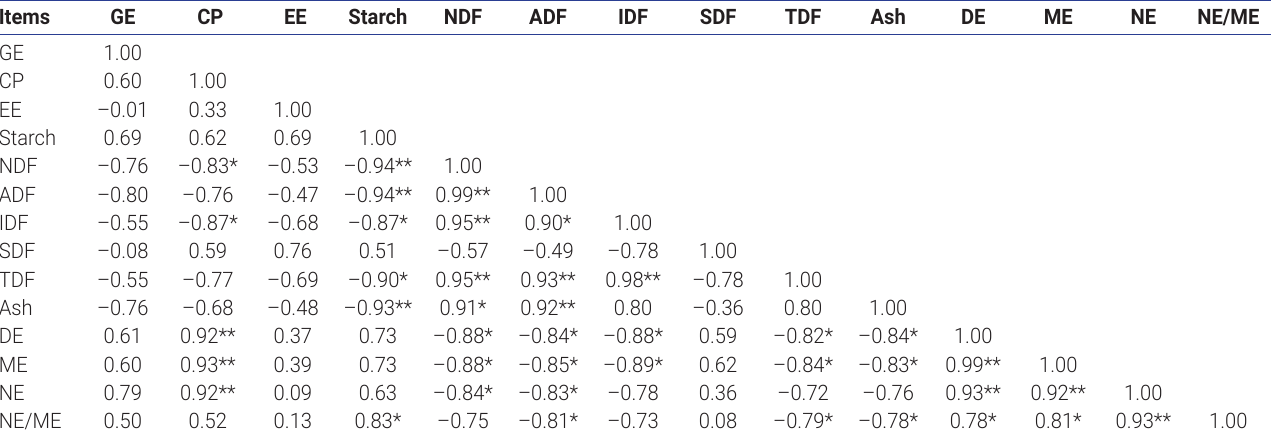
Table 6. Correlation coefficients between chemical characteristics and energy values of the experimental ingredients Items